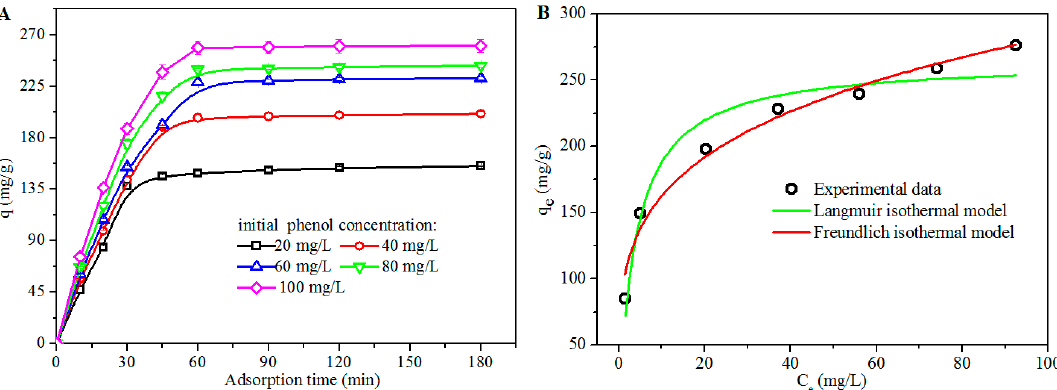
Figure 5. ( A ): The influence of adsorption time on the q values of Pc-rGBC at various initial phenol concentrations at 50 °C. ( B ): Equilibrium adsorption isotherm of phenol adsorbed onto Pc-rGBC at 50 °C. Points: experimental data; red line: Freundlich model; blue line: Langmuir model.